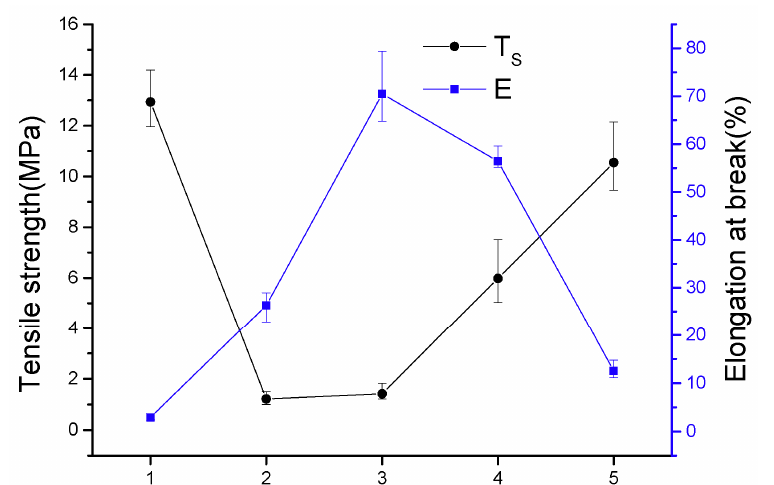
Figure 5. Mechanical properties of the film solutions of SPI and fractioned products: (1) SPI, (2) lower protein, (3) upper protein, (4) 11S globulin, and (5) 7S globulin.